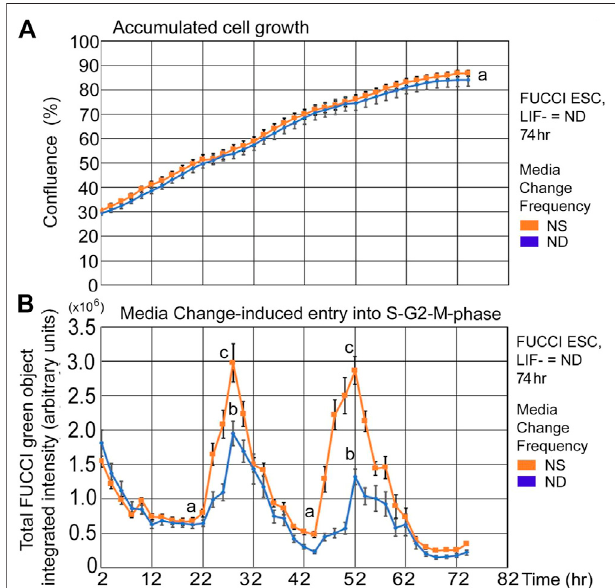
FIGURE 4 | FUCCI ESCs have similar rates of con fl uence increase and fed/unfed induced entry into the S-G2-M-phase during normal differentiation as in normal stemness culture. FUCCI ESCs were passed into 96-well plates and had medium change of either NS/LIF + or ND/LIF- media at Tzero, 24, and 48 h and then assayed for con fl uence and FUCCI total object green intensity in a IncuCyte Zoom live imager. (A) Cells were measured in time- lapseevery2 hoursforcon fl uenceintheliveimager. (B) FUCCIESCswerefed at 24-h frequency and assayed for green fl uorescence in time-lapse every 2 h from 2 – 74 h. Statistical comparisons from six independent biological experiments: Panel 4A : no signi fi cant difference between con fl uence at any timepoint and Panel 4B: Nadirs (a) are signi fi cantly different than peaks ( p < 0.0001). Peaks for NS (c) are signi fi cantly larger than for ND (b) ( p < 0.0001).